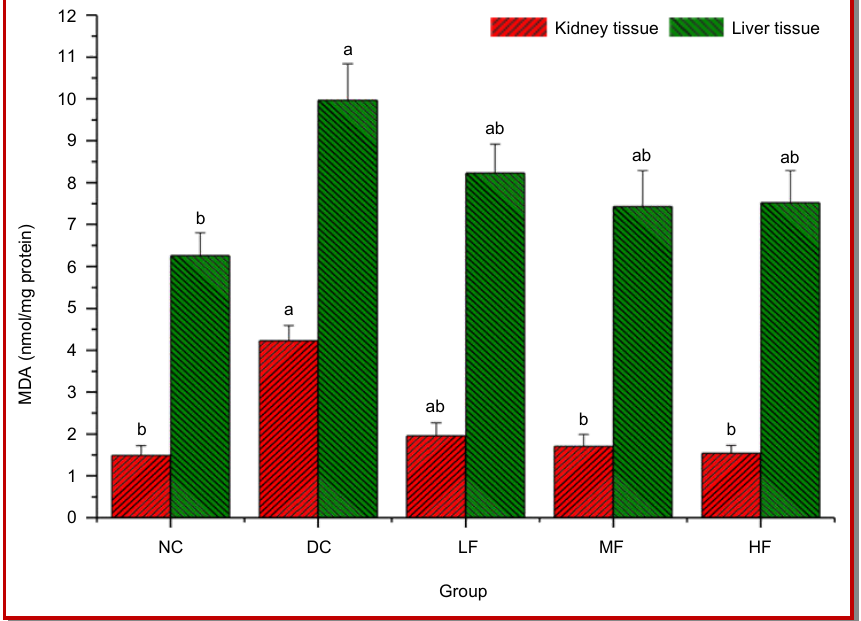
Figure 5: Effects of FTB on MDA contents in kidney and liver in mice; NC means normal control; DC means diabetic control; Dia- betic mice received low dose (LF) , middle dose (MF) and high dose (HF) of